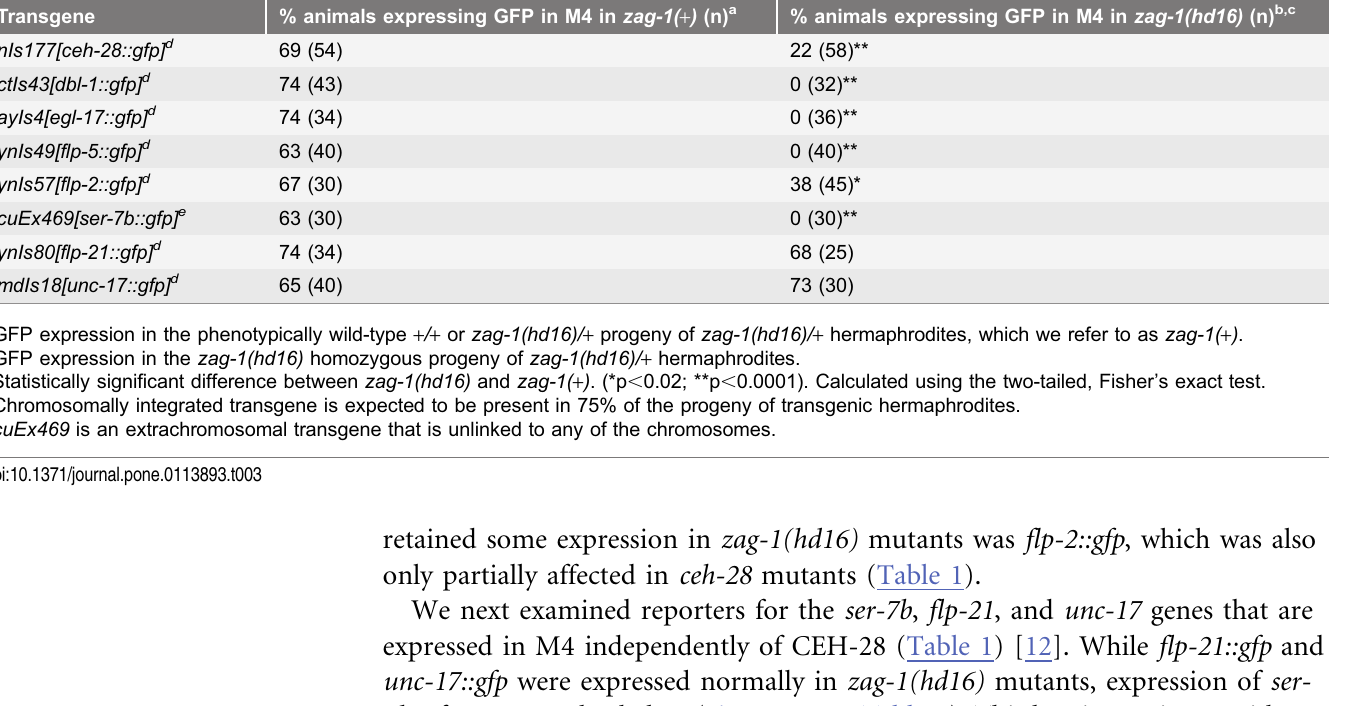
Table 3. Expression of M4 differentiation markers in zag-1( + ) and zag-1(hd16) mutants. Transgene